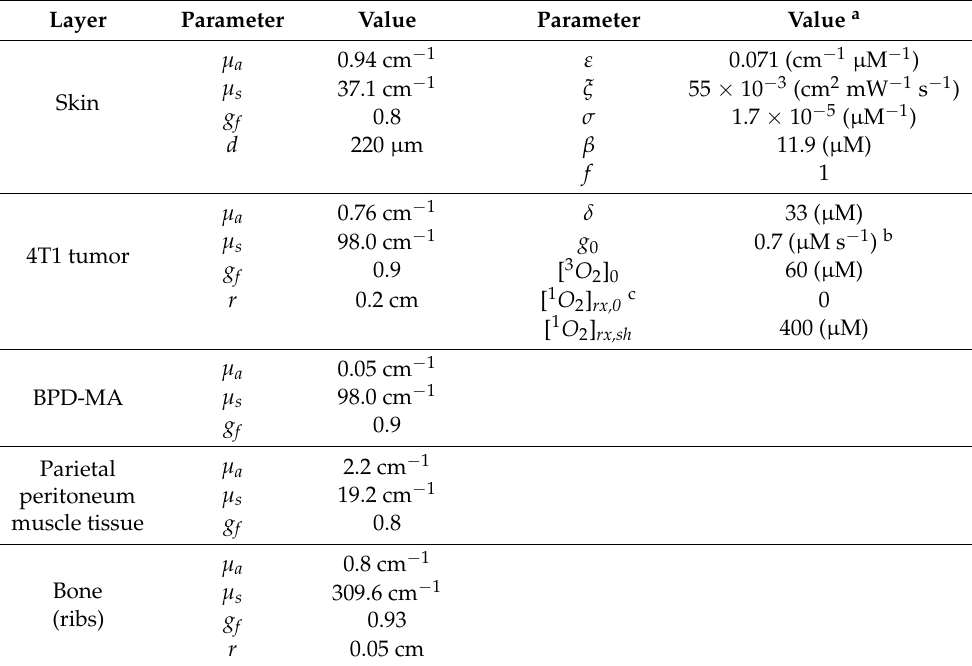
Table 2. Optical and photochemical properties of the PDT simulation model. Layer